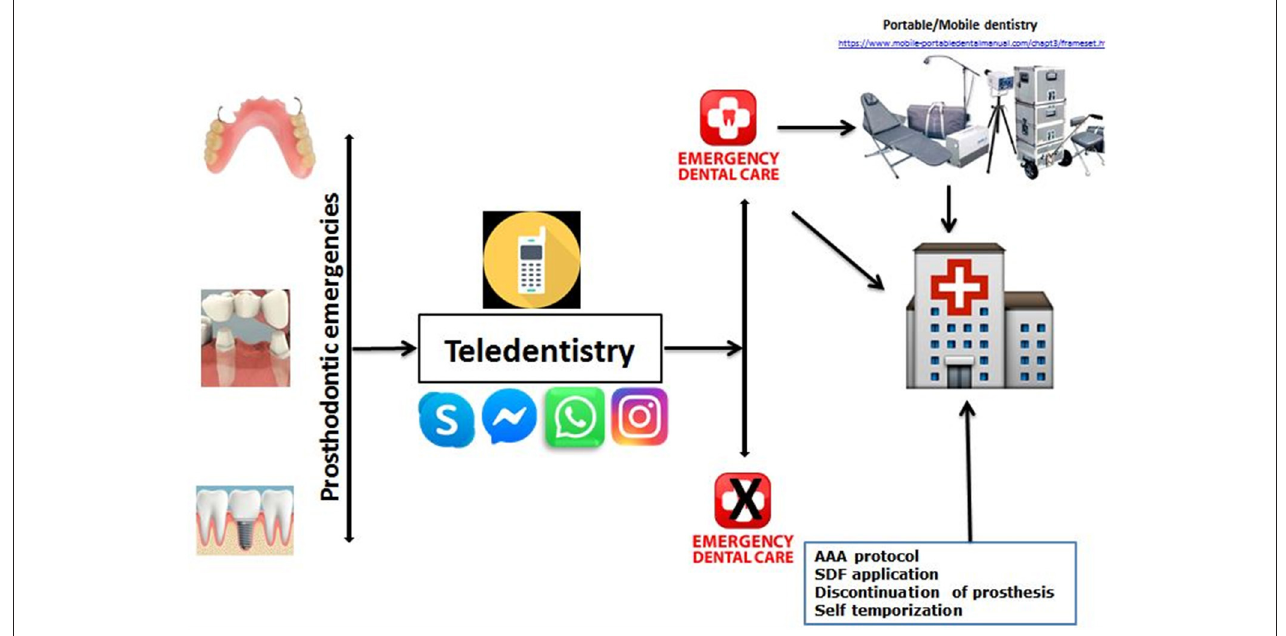
FIGURE 1 | Proposed model for the management of prosthodontic problems in geriatric